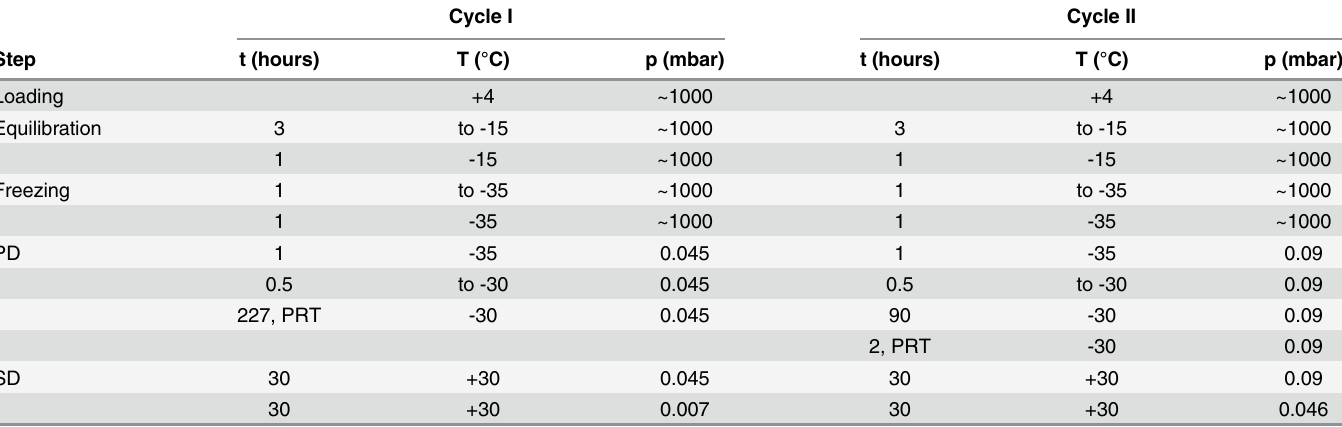
Table 1. Freeze-drying protocols as used in this study (PD = primary drying, and SD = secondary drying). The pressure rise test (PRT) in cycle I was used to confirm the end of primary drying. In cycle II the PRT was used during primary drying and after not meeting the criterion (maximum rise in pressure < 0.03 mbar/min) the primary drying stage was prolonged by an additional 2